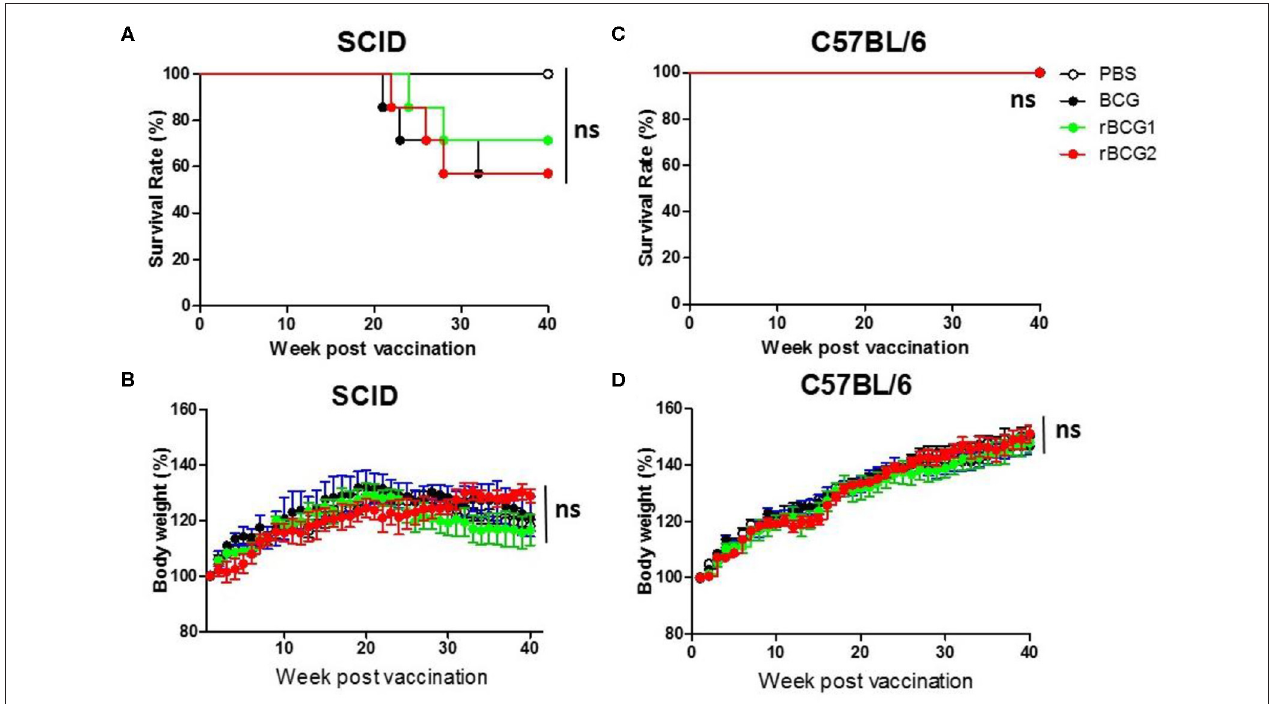
FIGURE 2 | Test of rBCG vaccine safety in immunodeficient and immunocompetent mice. SCID and C57BL/6 wild-type mice were immunized with BCG, rBCG1, or rBCG2 at weeks 0 and 2 ( n = 10). (A,C) Survival rate of SCID and C57BL/6 mice after vaccination. (B,D) The body weights of SCID and C57BL/6 mice were recorded every week. Body weight (%) was calculated as: weight (week n)/weight (week 0) per mouse. Survival curves were plotted by the Kaplan-Meier method. The Log-rank test was performed to compare each pair of survival curves ( P > 0.05; ns, non-significant). Differences among groups were determined by two-way